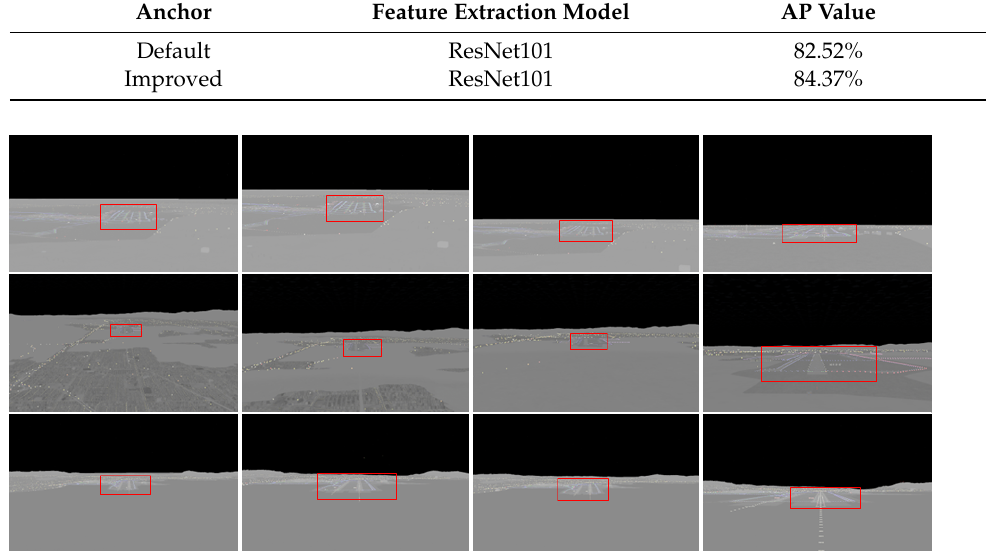
Figure 17. Runway detection results with default anchor size.